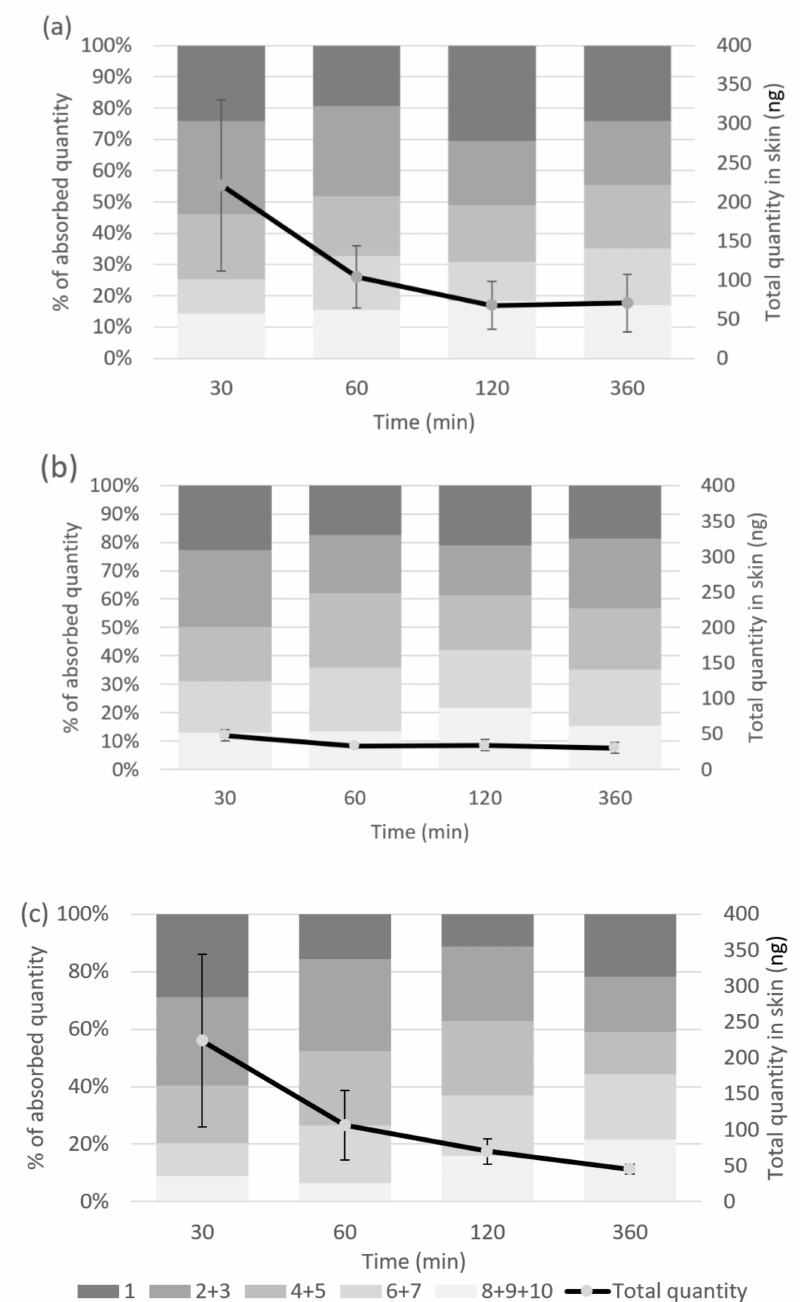
Figure 3. Profile of penetration of ( a ) RJDS, ( b ) RJL and ( c ) royal jelly in stratum corneum (SC) after application on the skin of healthy